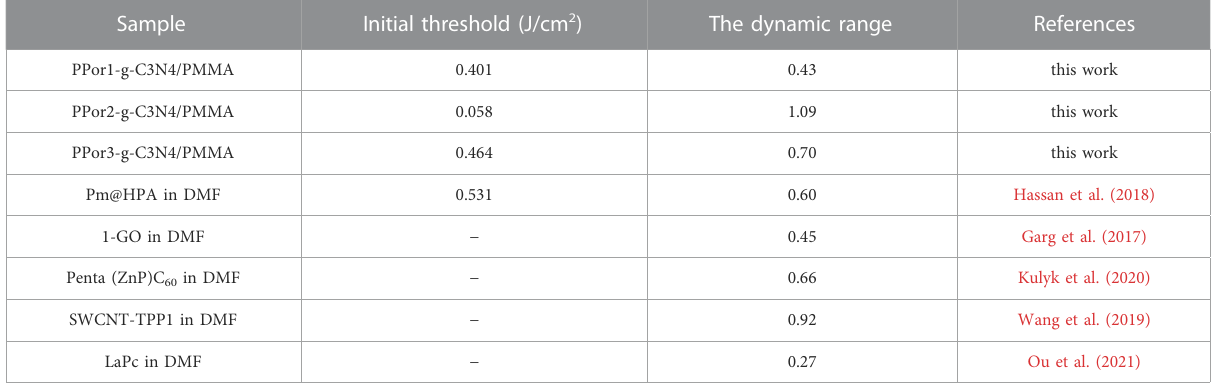
TABLE 3 Summary of the OL parameters of PPorx-g-C 3 N 4 /PMMA and reported works.